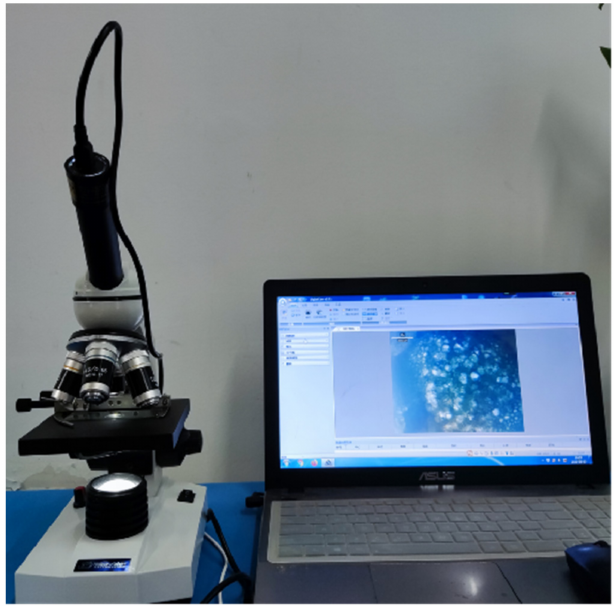
Figure 5. Microscopic view of the stalk